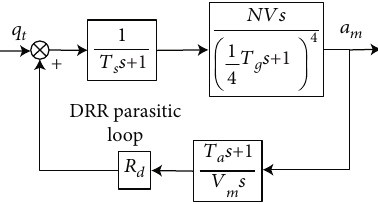
Figure 17: Frame of the parasitic loop of the inverted roll